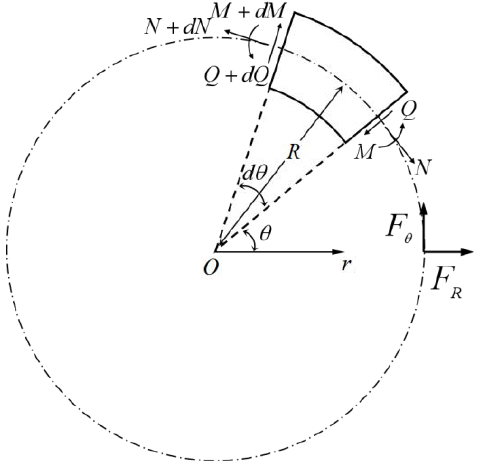
Figure 7. Force analysis of a micro-segment in the annular node.